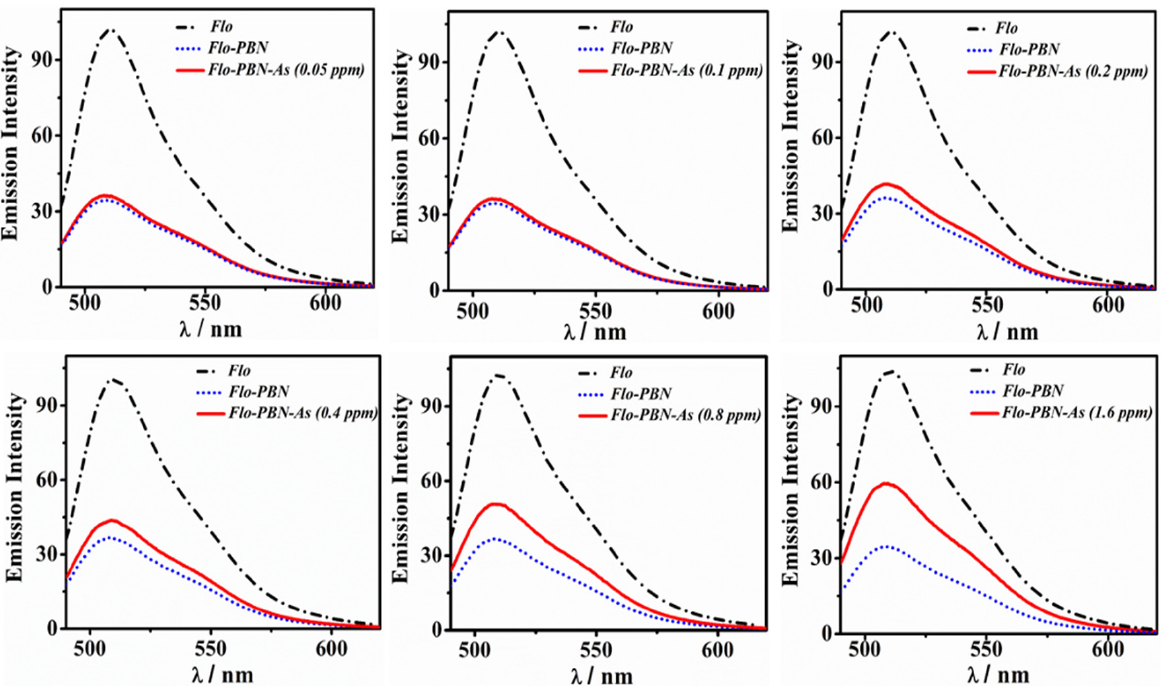
Figure 7. Study of the influence of As(III) addition over the emission spectra of the quenched Flo-PBN system by adding different concentrations of As(III) solution (0.05–1.6 ppm) and keeping a constant concentration of Flo (0.2 mM) and PBN (0.3 mM).